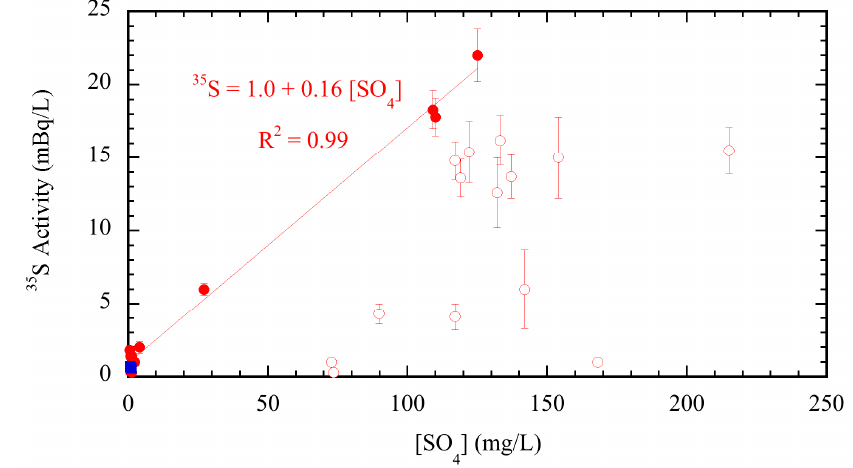
Figure 4. 35 S activities and [SO 4 ] from source water samples at the OCWD MAR site. The data is from